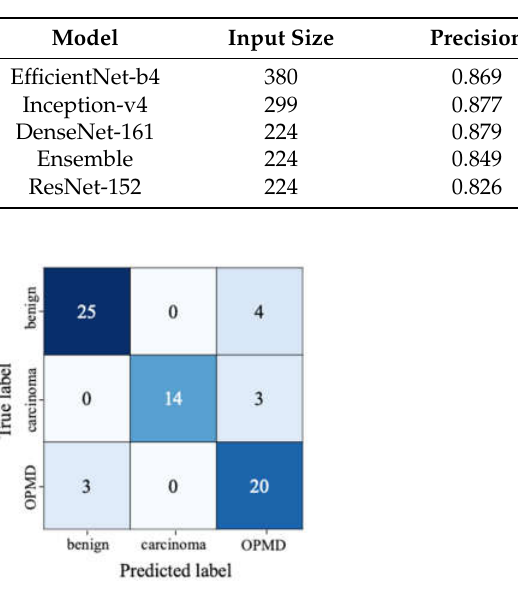
Table 6. Classification results of different CNN models on the test set of cropped lesion regions with the best model checkpoints. Precision, recall, and F 1 -score are reported as weighted macro-